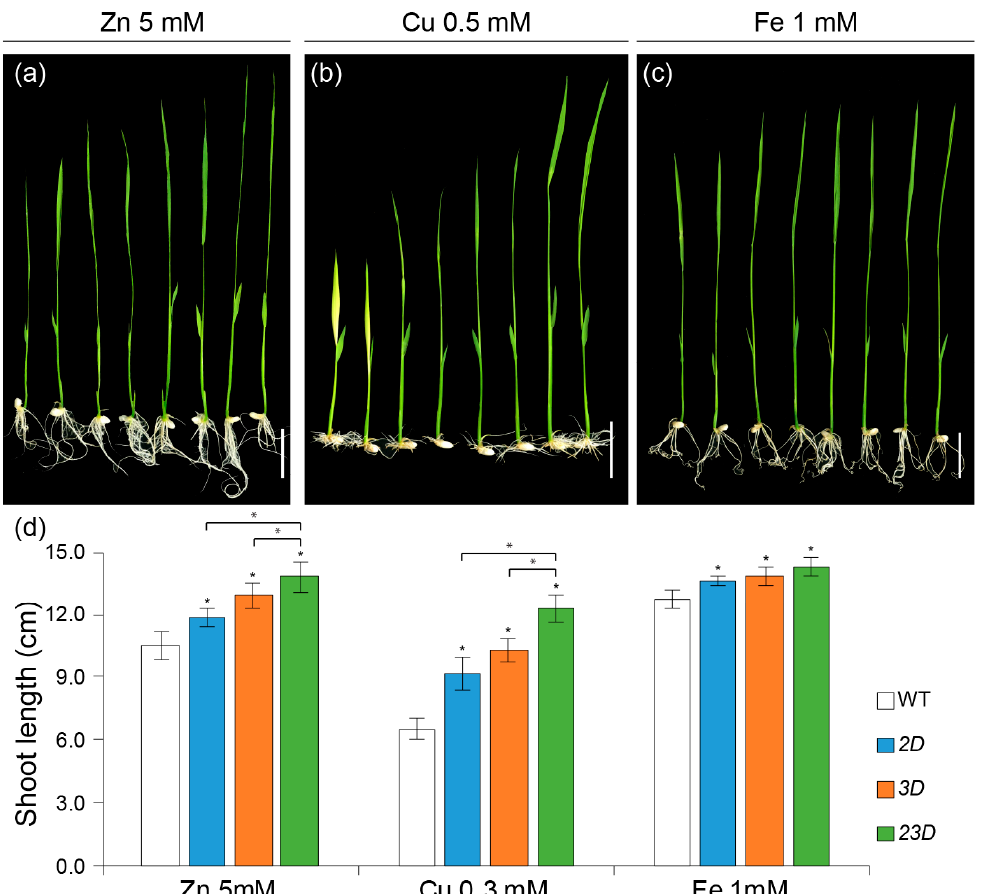
Figure 7. Growth test under the excess metal treatment. ( a – c ) Phenotypes of WT, 2D , 3D , and 23D grown on half-strength MS solid containing 5 mM ZnSO 4 ( a ), 0.5 mM CuSO 4 ( b ), or 1 mM FeCl 3 ( c ) for 10 days. Bars = 5 cm. Shoot lengths ( d ) of WT and activation-tagged mutants. Data are mean ± SE (n = 8), and significant differences among mutants and WT plants are indicated with an asterisk (* p < 0.05 by Student’s t -test).